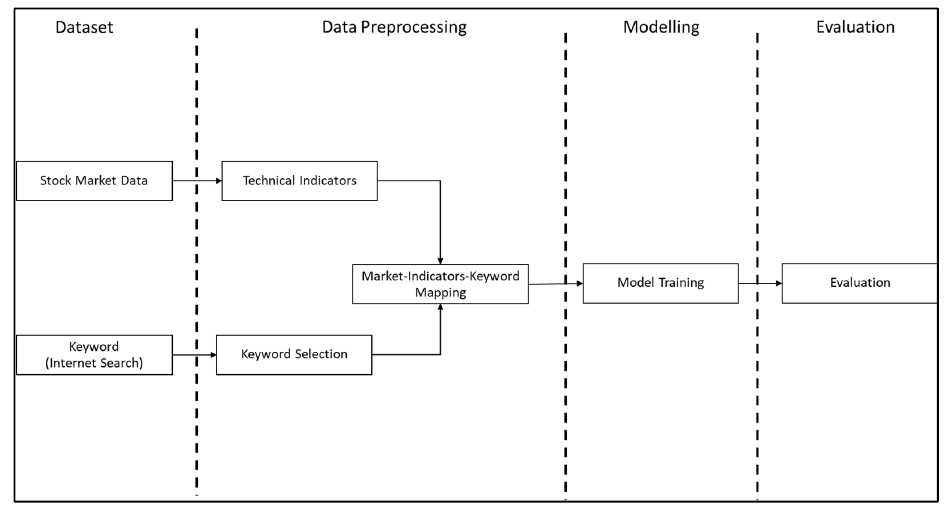
Figure 1. Generic common system components diagram.